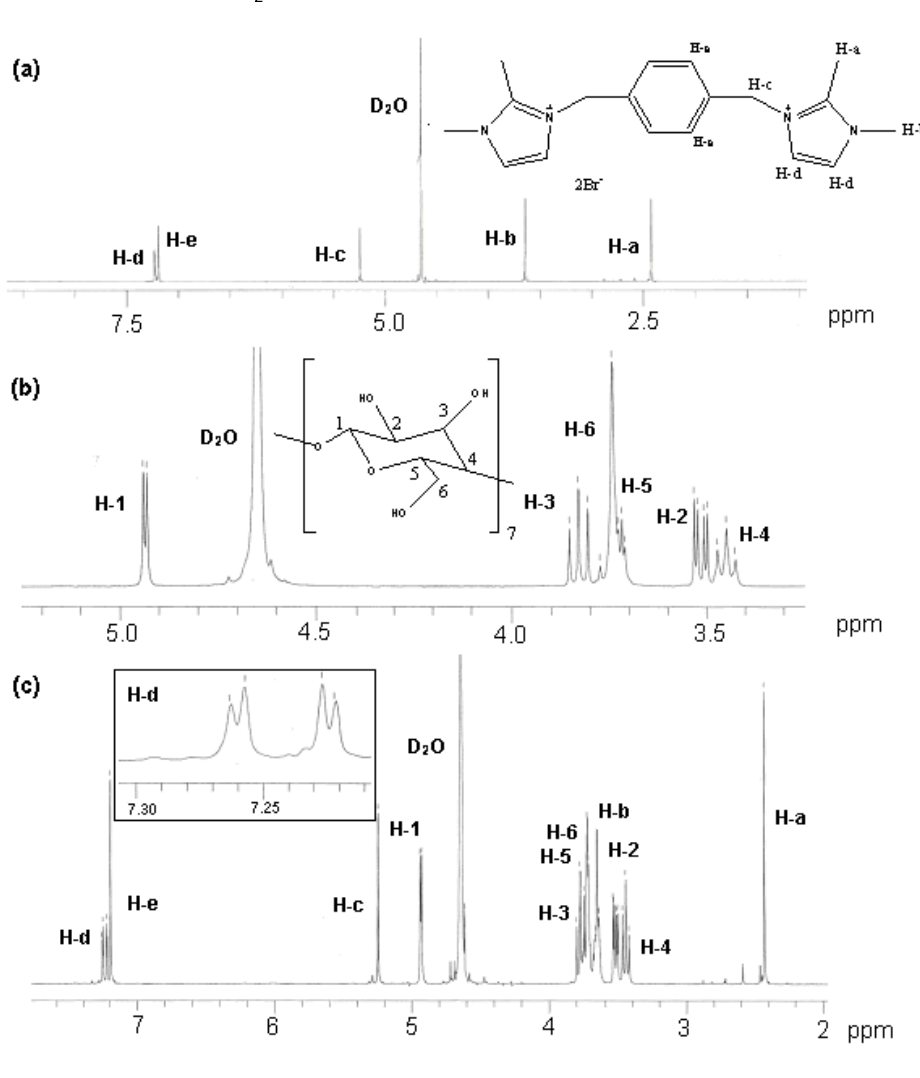
Figure 6. 400-MHz 1 H NMR spectra of (a) TetraPhimBr, (b) β-CD and (c) β-CD-TetraPhimBr in D